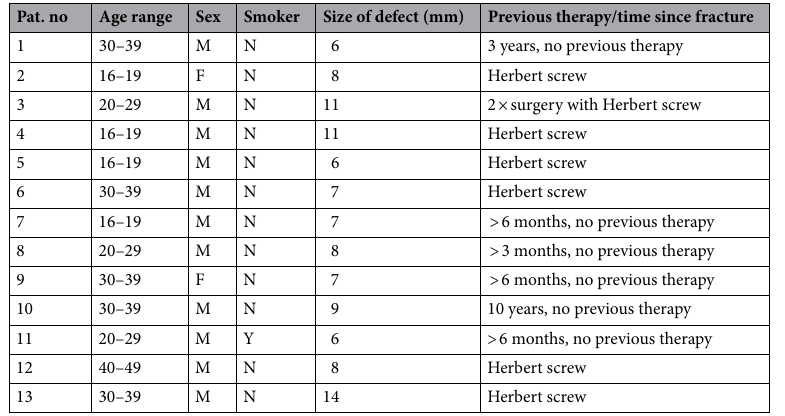
Table 1. Epidemiology of the patient group. All patients signed written ‘consent for publication’.